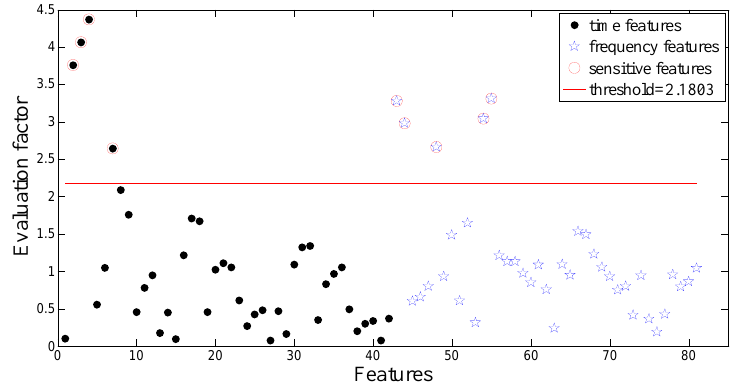
Figure 15. The evaluate factor of all the extracted features in the planetary gearbox test.